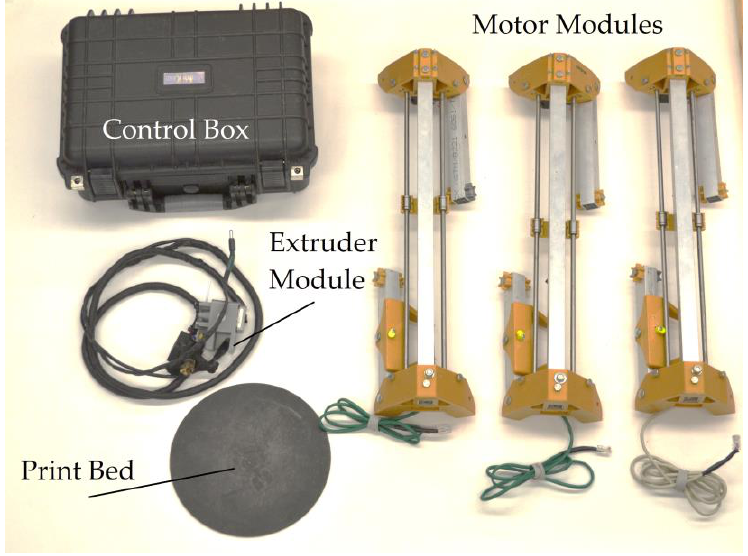
Figure 3. The Kijenzi divided into modules and labeled.